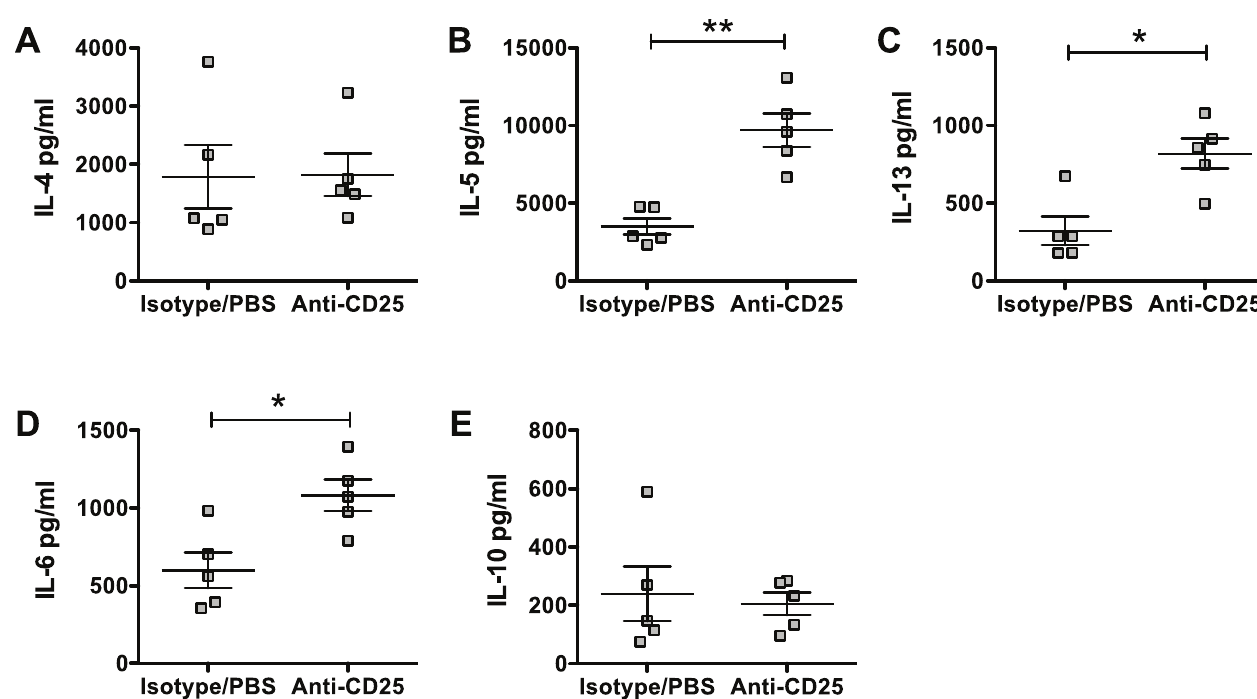
Fig 7. Antigen-specific cytokine secretion by MLN cells from infected Irf8 -/- mice treated with anti-CD25 mAb. Singlecell suspensionsof MLN were preparedfrom infected Irf8 -/- mice treated with isotype control antibody or anti-CD25mAb on day 14 p.i. The cells were stimulatedin vitro with 50 μ g AWH, supernatants were harvested48 h later, and cytokine levels were determined using a Bio-Plex assay. (A) IL-4, (B) IL-5, (C) IL-13, (D) IL-6, and (E) IL-10 levels. Data from individualmice are presented as pg/ml and were calculatedbasedon internalstandards for each cytokine with the mean ± SEM for each group shown. n = 5 mice per group. * , p (cid:20) 0.05; ** , p (cid:20) 0.01.